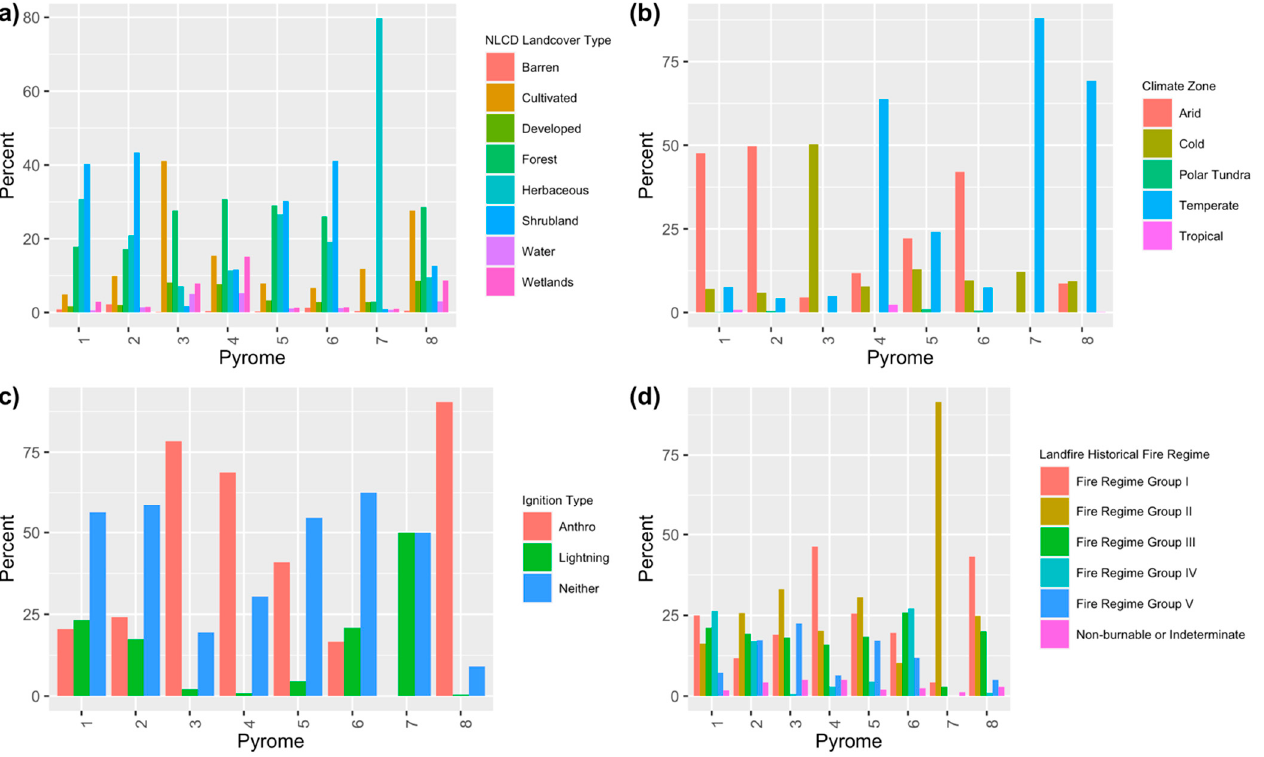
Figure 2. Percent of each of the eight pyromes in the contiguous U.S. occupied by each of the primary controls of fire: vegetation, climate, and ignitions: ( a ) 2016 National Land Cover Database (NLCD), ( b ) temperature- and moisture-based climate zones (Koppen–Geiger climate classification), and ( c ) ignition type, as well as ( d ) LANDFIRE historical fire regime group (FRG) category. FRG Group I: ≤ 35-year fire return interval, low and mixed severity; FRG Group II: ≤ 35-year fire return interval, replacement severity; FRG Group III: 35–200-year fire return interval, low and mixed severity; FRG Group IV: 35–200-year fire return interval, replacement severity; FRG Group V: >200-year fire return interval, any severity. A grid cell was considered dominated by anthropogenic or lightning ignitions if over 75% of ignitions in that grid cell were human or lightning-caused, respectively .